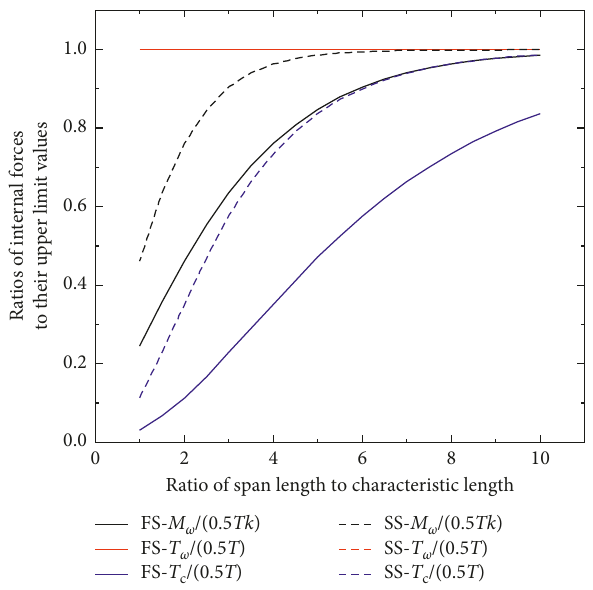
0 . 5 Tk cosh 0 . 5 L / k 1 /sinh 0 . 5 L / k ; D 0 . 5 Tk sinh 0 . 5 L / k / (cid:31) ([ ( ) ] ( )) (cid:31) · ( ) −